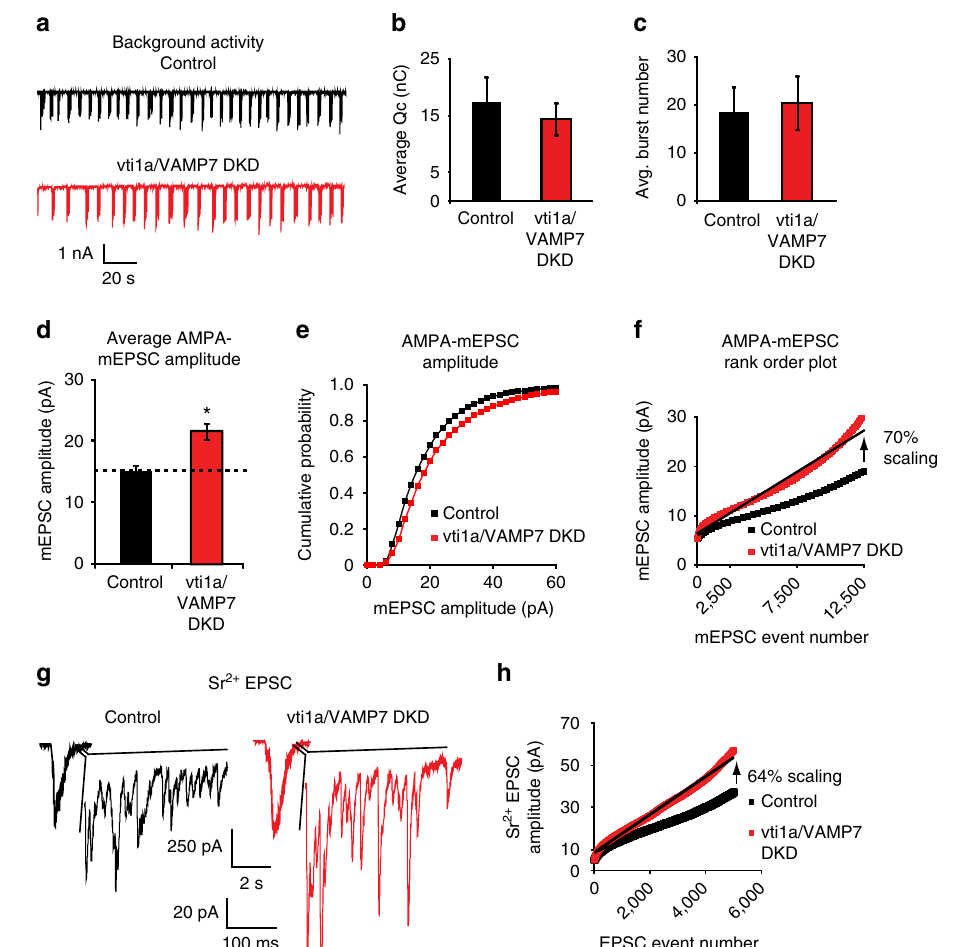
Figure 3 | Vti1a and VAMP7 loss elicits scaling of unitary event amplitudes without changes in excitatory network activity. ( a ) Representative traces showing background network activity recordings from control and vti1a/VAMP7 DKD neurons cultured from rat hippocampus. ( b ) No differences were seen in average total charge transfer between control and vti1a/VAMP7 DKD neurons from 3min of recording (control: n ¼ 9 neurons from three independent cultures; vti1a/VAMP7 DKD: n ¼ 10 neurons from three independent cultures; P ¼ 0.55). ( c ) No differences were seen in average burst number between control and vti1a/VAMP7 DKD neurons during background network activity analysed in b ( P ¼ 0.82). ( d ) Average AMPA-mEPSC amplitudes from vti1a/VAMP7 DKD neurons were significantly increased compared with control neurons from recordings analysed in Fig. 1d ( P ¼ 0.0005). ( e ) Cumulative probability histograms of AMPA-mEPSC amplitudes from recordings analysed in Fig. 1d (Kolmogorov–Smirnov test; P ¼ 0.0001). ( f ) Rank-order plot of AMPA-mEPSC amplitudes from recordings analysed in Fig. 1d. The slopes of the linear fits indicate a multiplicative increase (70% scaling) in vti1a/VAMP7 DKD neurons. ( g ) Representative traces showing evoked asynchronous unitary EPSC recordings in the presence of Sr 2 þ and absence of Ca 2 þ in control and vti1a/VAMP7 DKD neurons. The top scale refers to the evoked bulk events and the bottom scale refers to the enlarged insets showing asynchronous unitary EPSCs. ( h ) Rank-order plot of asynchronous evoked unitary AMPA-EPSC amplitudes from control and vti1a/VAMP7 DKD neurons (control: n ¼ 5 recordings from three independent cultures; vti1a/VAMP7 DKD: n ¼ 4 recordings from two independent cultures). The slopes of the linear fits of the two curves indicate a multiplicative increase (64% scaling) of unitary event amplitudes in vti1a/VAMP7 DKD neurons compared with control neurons.